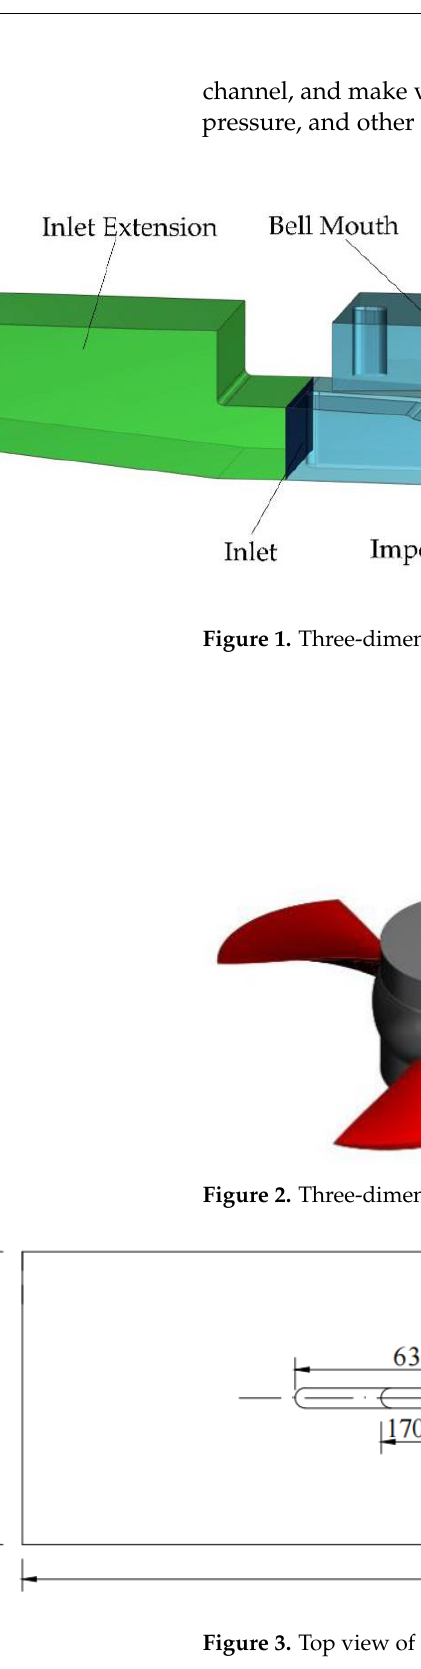
Figure 3. Top view of the full flow path of the pumping station.